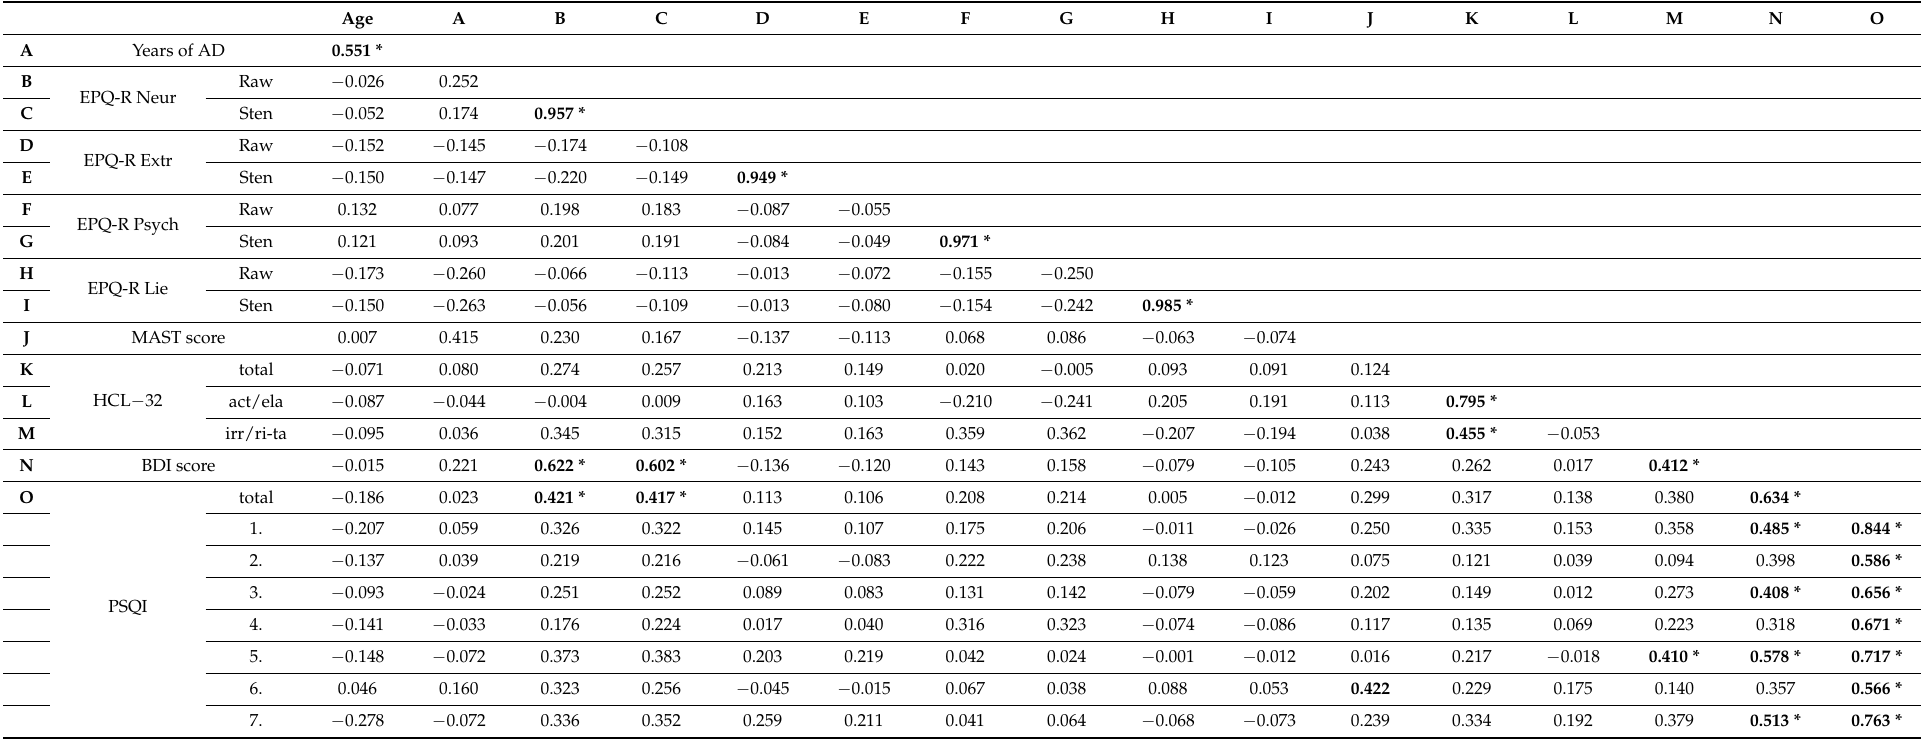
Table 4. Correlation matrix between continuous variables used in the